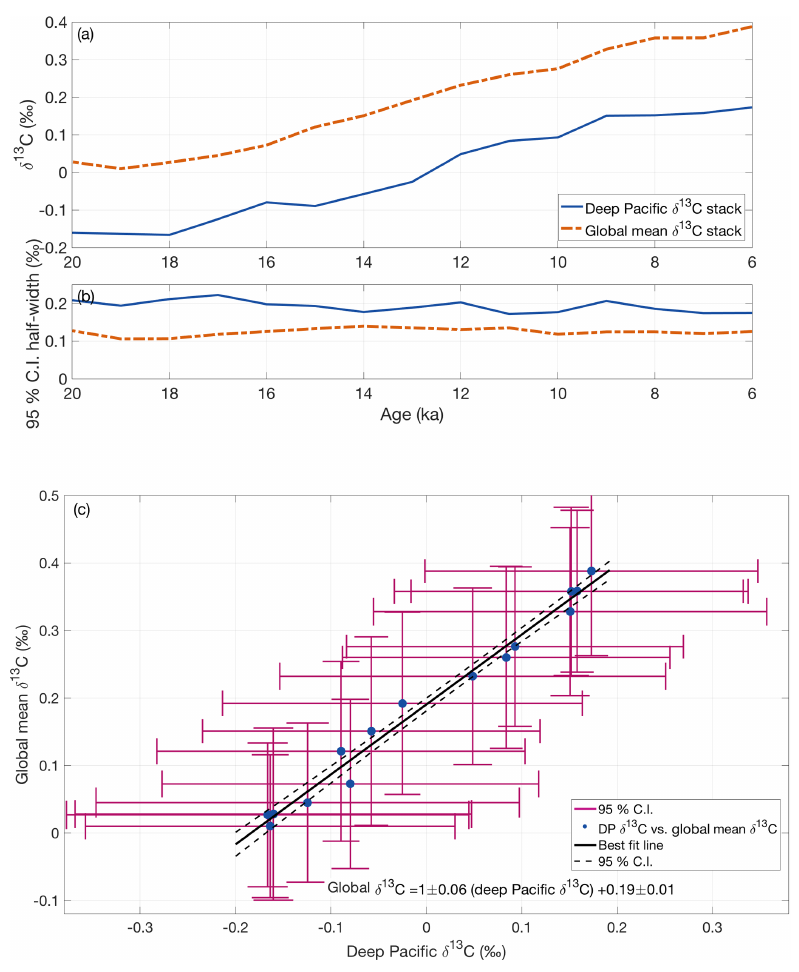
Figure 6. (a) Time series of global mean ocean δ 13 C stack and deep Pacific δ 13 C stacks. (b) Half-width 95% confidence intervals for the global mean stack and deep Pacific stack. (c) Deep Pacific δ 13 C stack vs. global mean δ 13 C stack. Each point is the δ 13 C value for one time slice with 95% confidence intervals (vertical and horizontal error bars). Time across the deglaciation progresses toward the upper right corner. The best-fit linear regression is plotted as a solid line with 95% confidence interval (dashed lines).